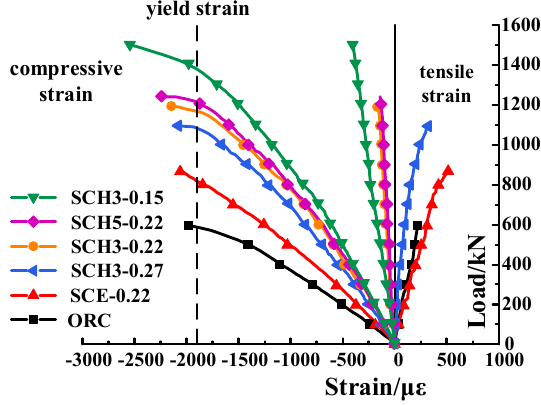
Figure 11. Load-strain curve of concrete and ECC.